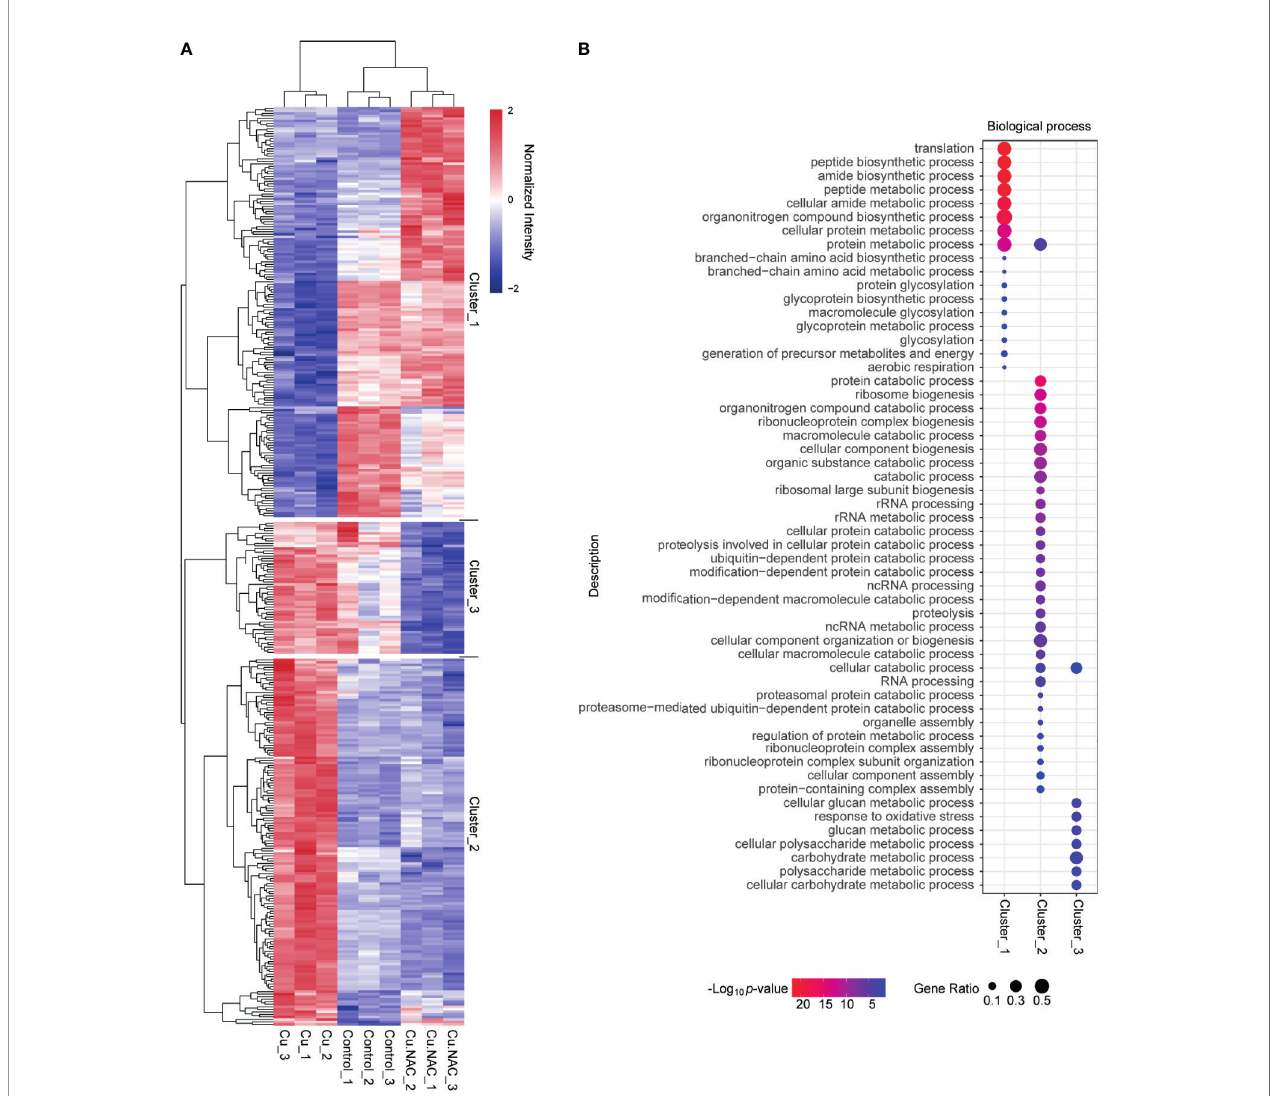
FIGURE 4 | Clustering-based Gene Ontology (GO) enrichment analysis of differentially expressed proteins following treatment with copper (Cu), Cu and N- acetylcysteine (NAC), or untreated (control). (A) Hierarchical clustering analysis of differentially expressed proteins under Cu stress. The x-axis represents the clustering of the samples and the y-axis represents the clustering of the differentially expressed proteins. The colors represent the relative expression levels of the proteins: the maximum value is red and the minimum value is blue. (B) Bubble diagram of enriched GO subcategories for the differentially expressed proteins in the three clusters, indicating p -values and protein